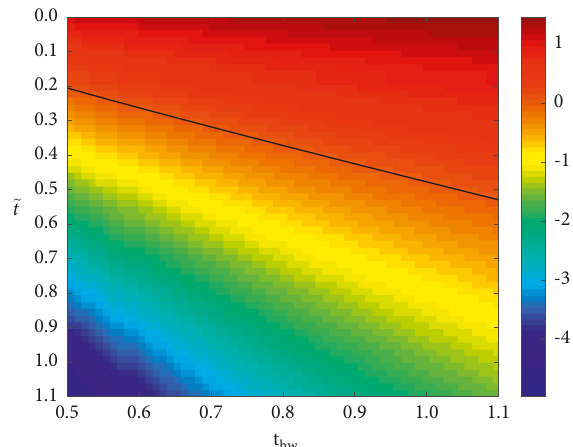
Figure 2: Stability values for CACC vehicles with communication failures.